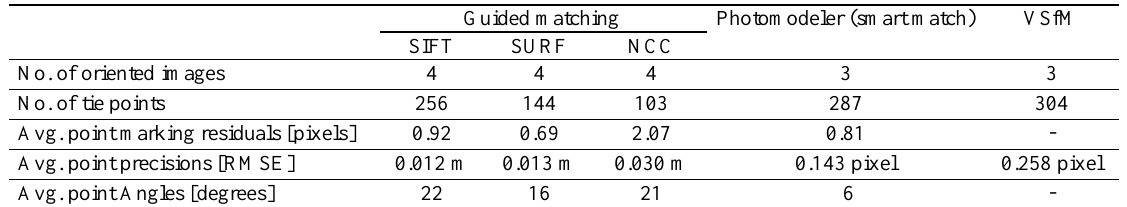
Table 2. Comparison of automated image orientation in different